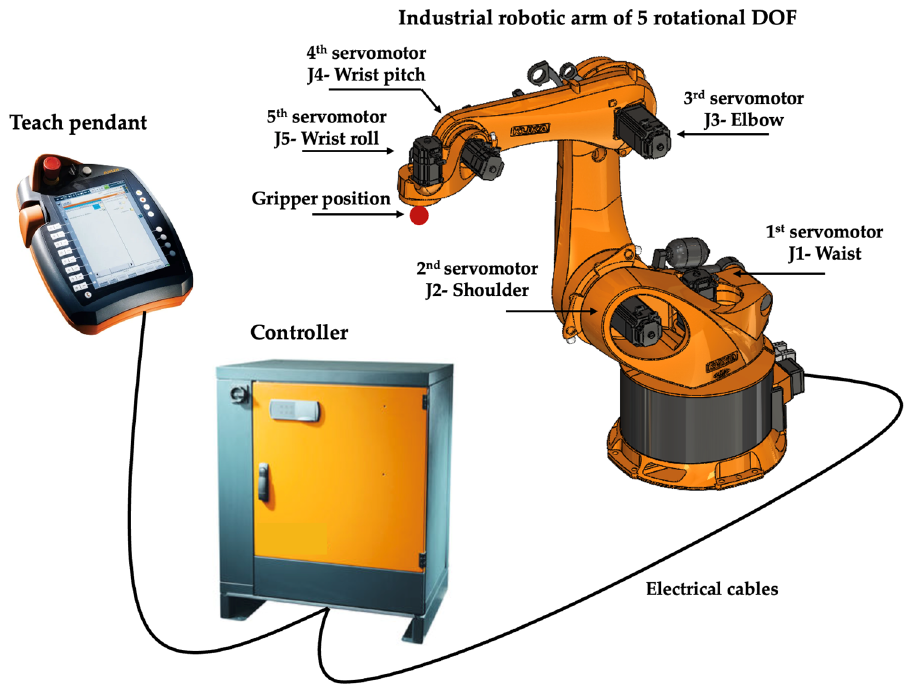
Figure 1. Elements of an industrial robot arm.